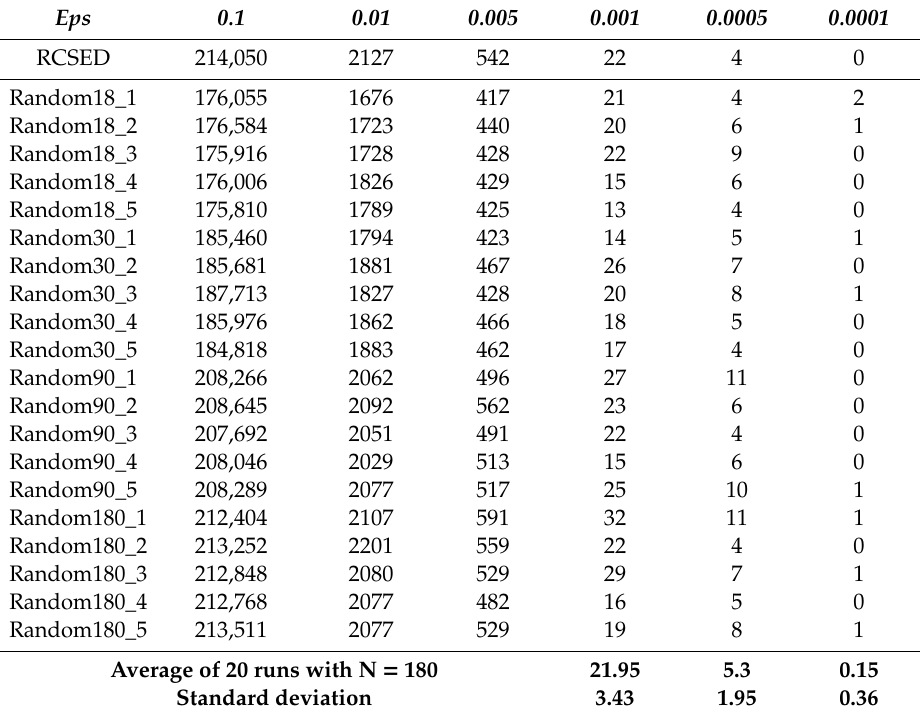
Table 20. Number of opposite pairs for selected angular accuracy values eps in the RCSED catalog and in several random catalogs with the same number of objects and the same angular distribution on the celestial sphere.